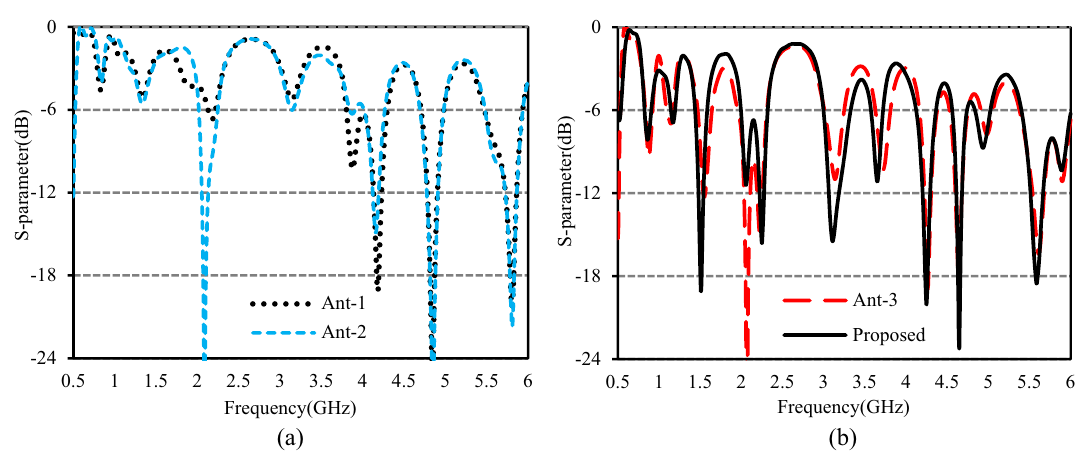
Figure 3. Simulated S-parameters for ( a ) Ant-1, and Ant-2, ( b ) Ant-3 and the proposed